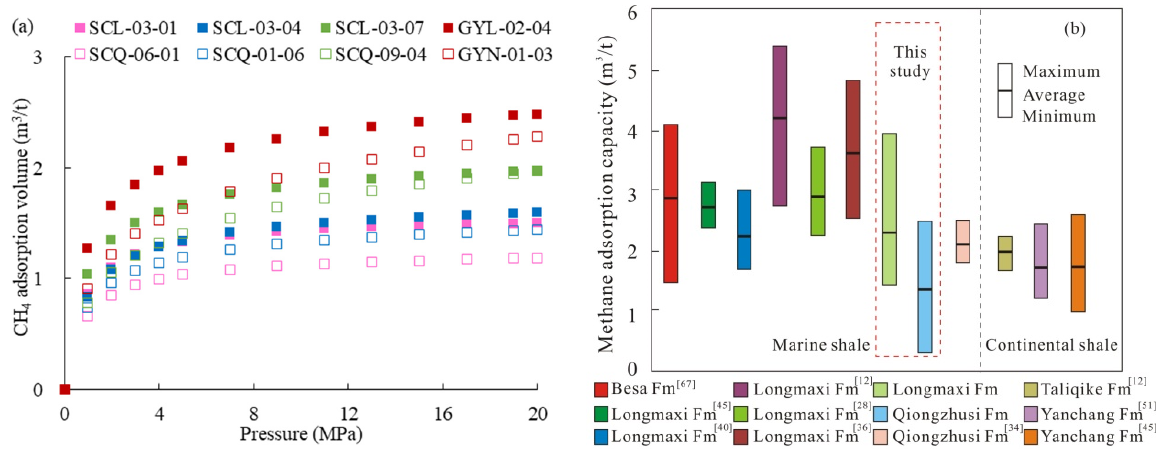
Figure 14. Methane isothermal adsorption curves ( a ) and gas content ( b ) of the Lower Paleozoic shale from the upper Yangtze plate.